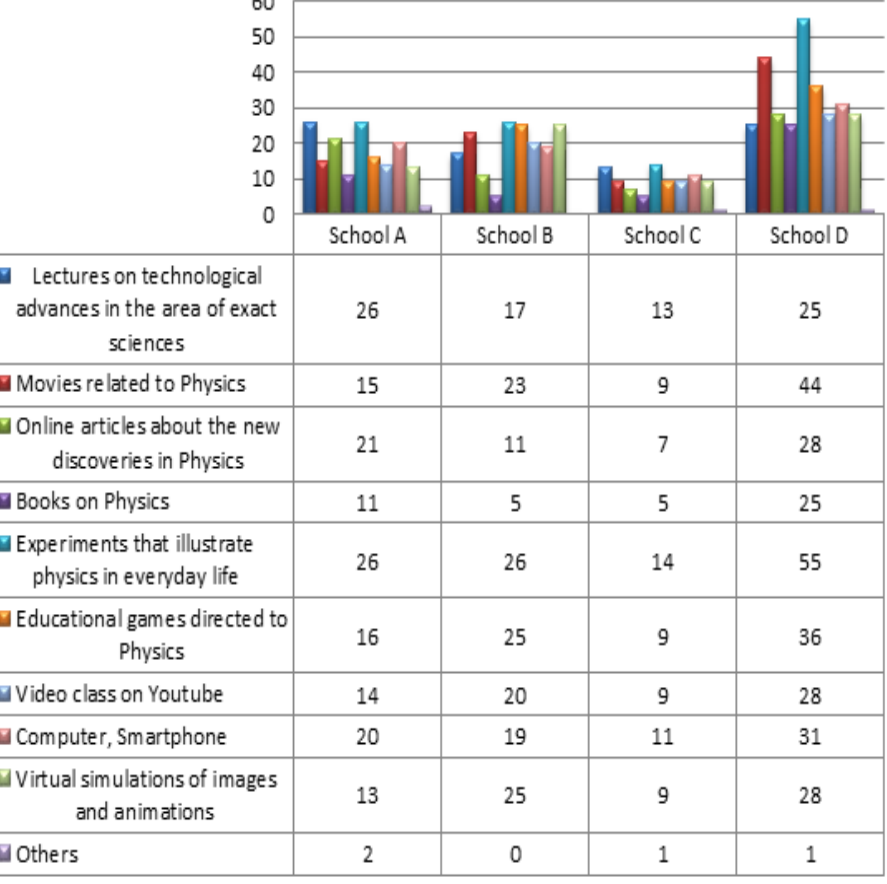
Table 1: Use of technological resources to aid the teaching of Physics in schools.